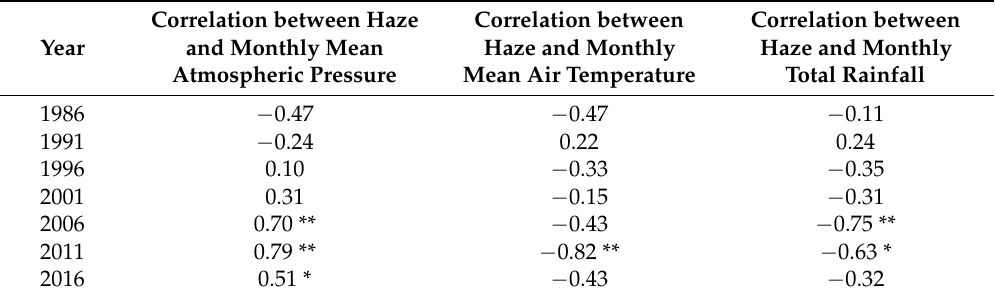
Table 4. Pair-wise correlations between haze and meteorological conditions.